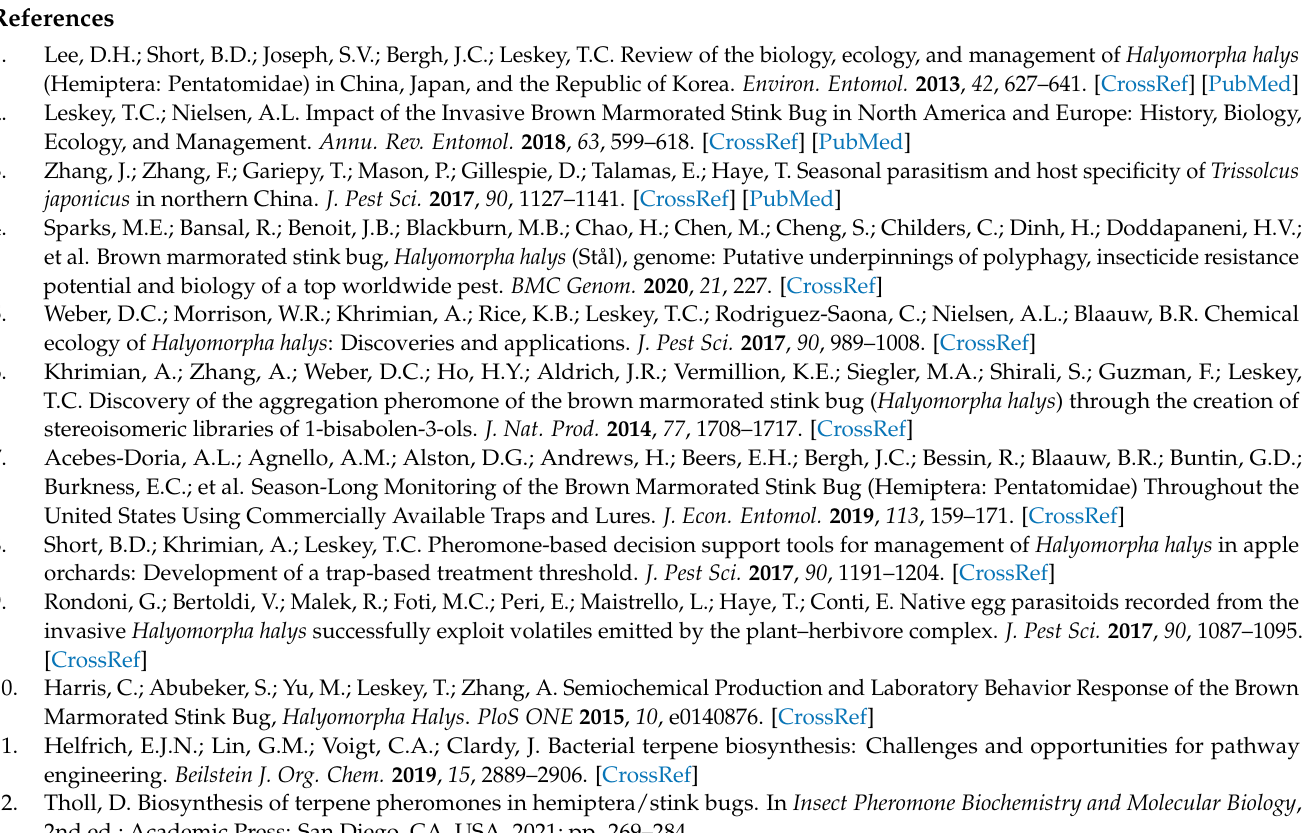
red module; Table S5: GO function enrichment result of red module. Figure S1. Sample clustering by WGCNA. Figure S2. Molecular docking schematic of Hh TPS1